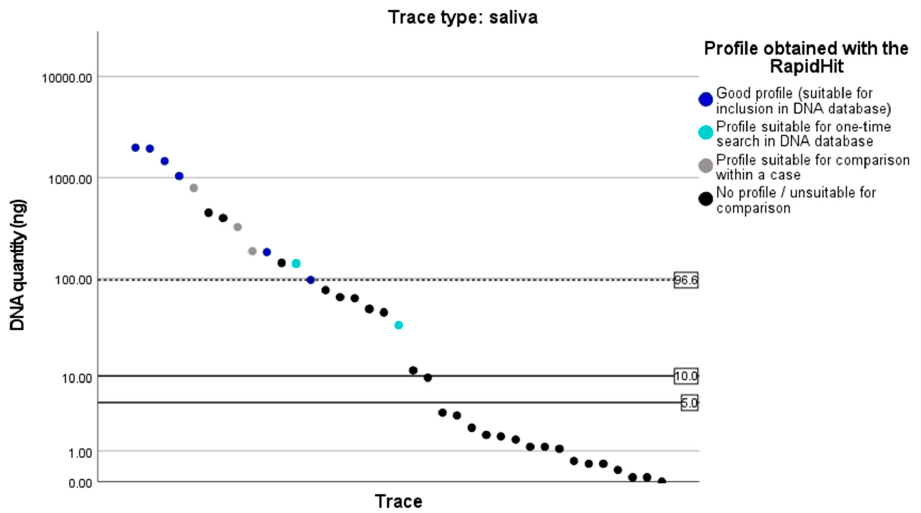
Figure A2. The distribution of the DNA quantity of saliva traces (n = 38) of the laboratory samples analyzed by the regular procedure linked with the profiles generated by the RapidHit. The dotted line is the point from which 46% of ‘good profiles’ were obtained. The solid lines are the stated threshold of the RapidHit to derive a full DNA profile 0.25 µ L of blood, containing 5–10